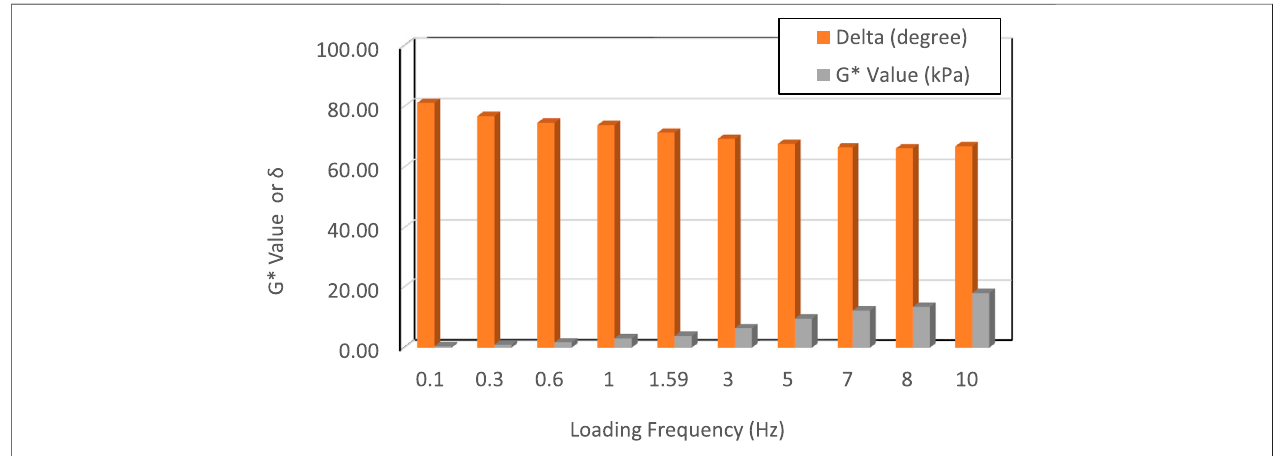
FIGURE3 | A histogram for shear complexmodulus(G*) and phase angle ( δ ) values versusloading frequency (sample: RTFO-aged 10%cement-modi fi edasphalt binder at 64 ° C).